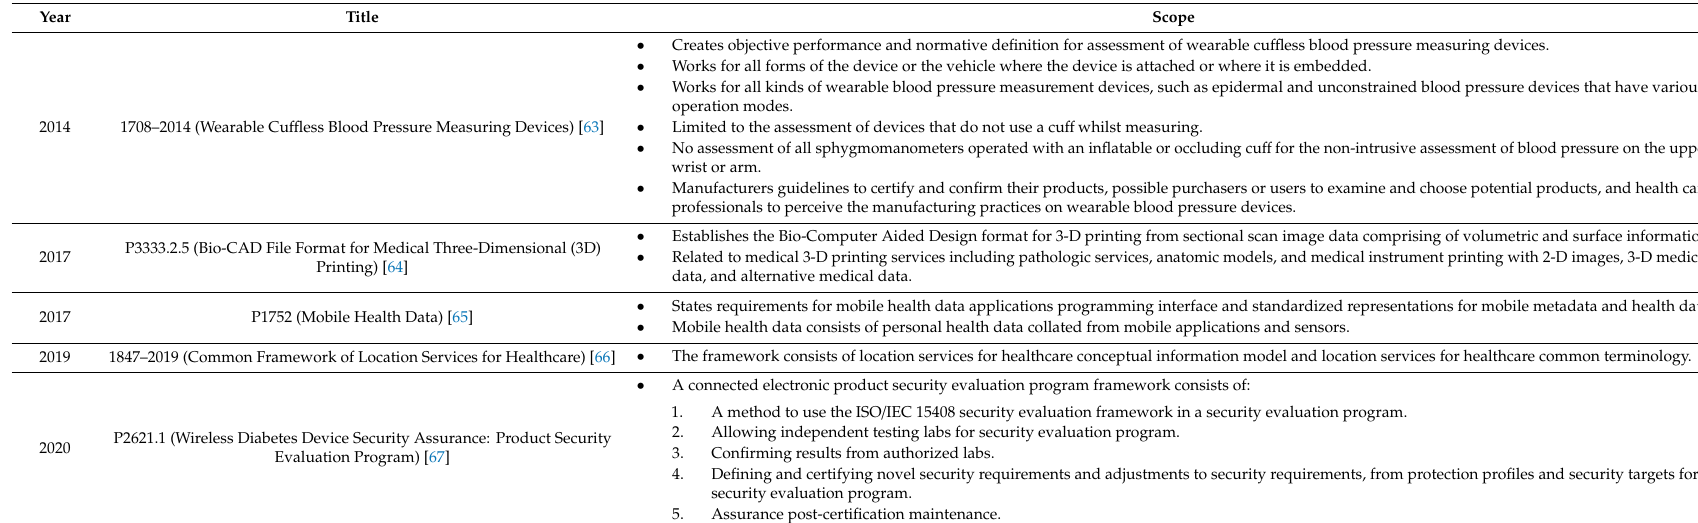
Table 2. Recent IEEE Standards in development for smart health.